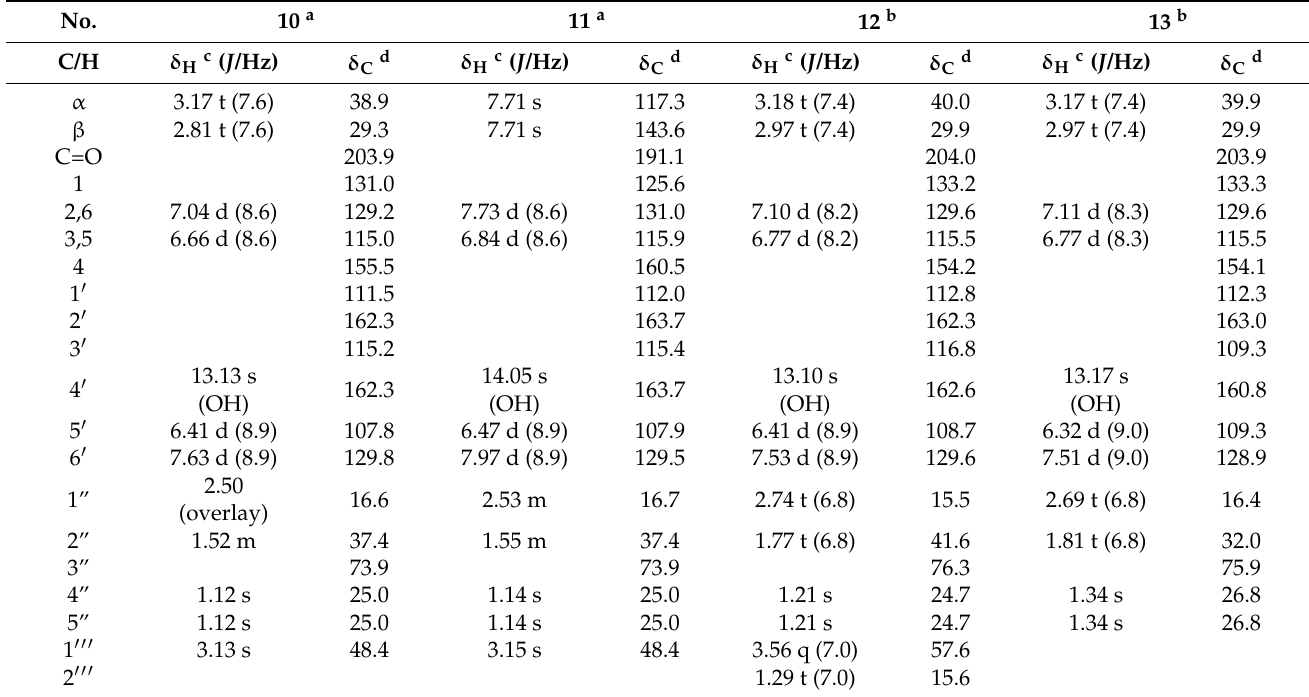
Table 2. 1 H- and 13 C-NMR data for 10 – 13